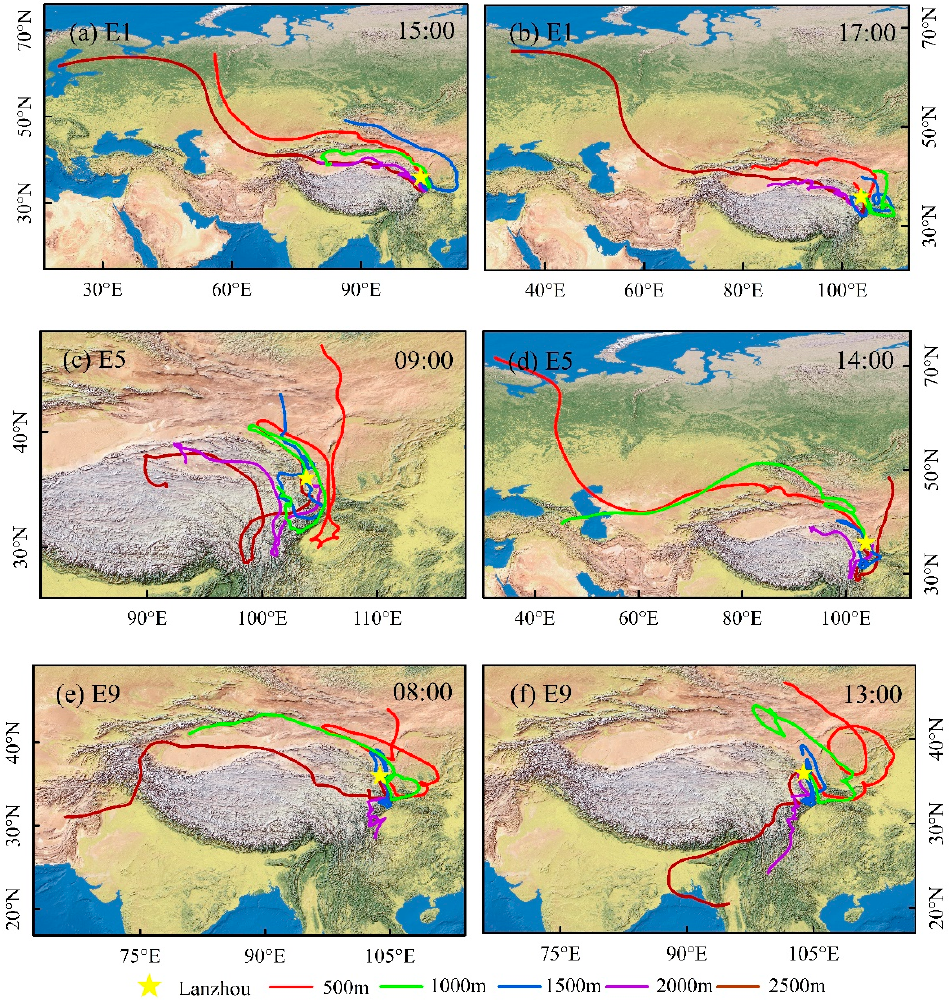
Figure 5. Moisture trajectories of the air mass for three individual precipitation events at different times during E1, E5, and E9. ( a ) E1, 15:00; ( b ) E1, 17:00; ( c ) E5, 09:00; ( d ) E5, 14:00; ( e ) E9, 08:00; ( f ) E9, 13:00.